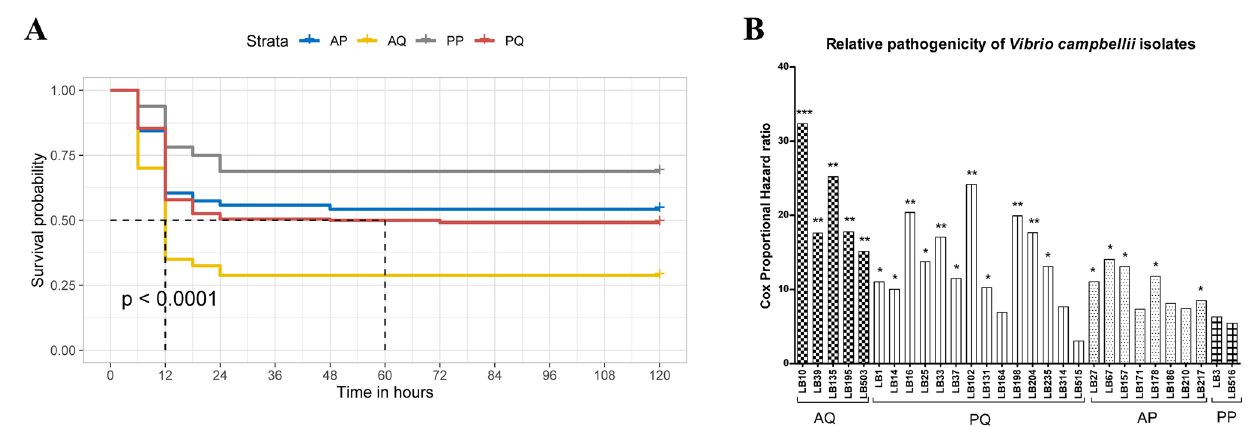
Figure 8. Pathogenicity of Vibrio campbellii in Penaeus vannamei juveniles. ( A ) Kaplan–Meier survival estimates of four variants of ToxR. ( B ) Relative pathogenicity of V. campbellii isolates against reference strain V. campbellii BAA-1116. The result was analysed by Cox proportional hazard analysis. The significance level is indicated at * (p < 0.05), ** (0.01) and *** (p < 0.001). The isolates within a ToxR variant is represented with a similar pattern. The AQ (A123Q150), PQ (P123Q150), AP (A123P150) and PP (P123P150) represents four variants of ToxR based upon amino acid at 123rd and 150th